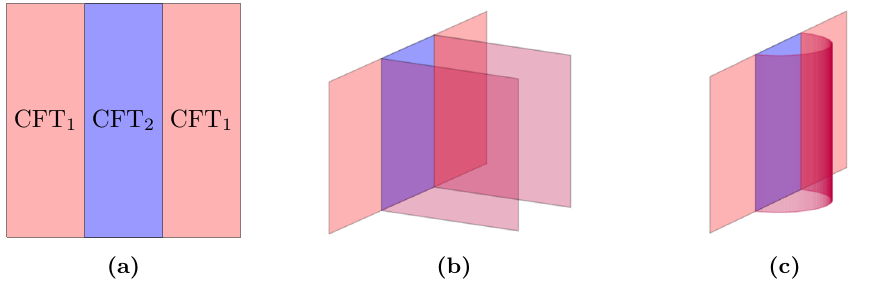
Figure 11. (a) Euclidean path integral geometry associated with the vacuum state of the in- terface CFT. (b), (c) Two possible topologies for the interface brane in the dual geometry. The configuration (b) is traversable from left to right but this requires crossing the interface brane. The configuration (c) is pleasantly